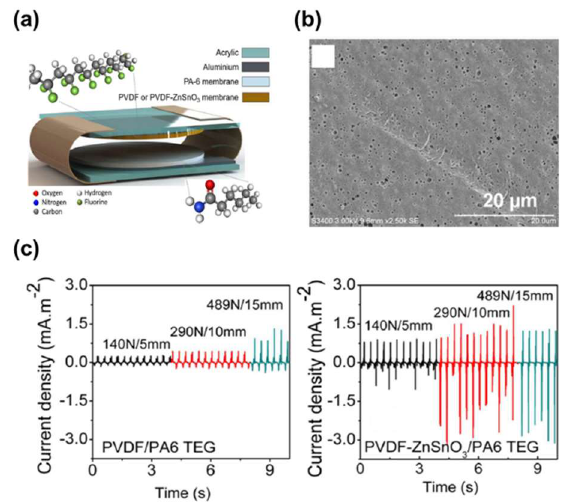
Figure 6. ( a ) The structure of the triboelectric nanogenerator (TEG) showing the position of the various components. ( b ) Scanning electron microscopy images of the surface and thickness cross-section of the PVDF-ZnSnO 3 membrane. ( c ) Short circuit current values for PVDF/PA6 TEG and PVDF-ZnSnO 3 /PA6 TEG. Reproduced with permission from Luo et al., Nano Energy 2016 , 30 , 470–480. Copyright 2016 Elsevier.